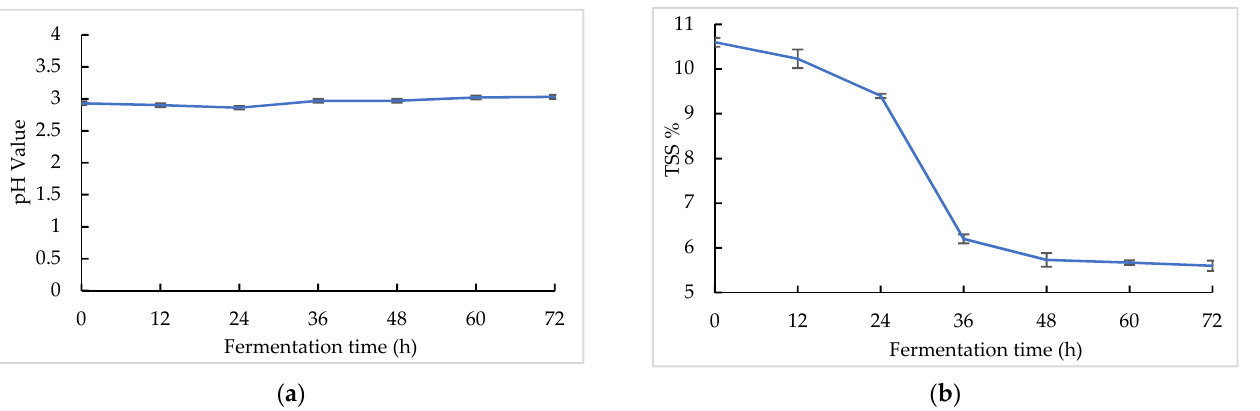
Figure 1. pH and TSS changes in sea buckthorn juice during fermentation: ( a ) pH change; ( b ) TSS change. 3.2. Color Changes in Sea Buckthorn Juice during Fermentation The color changes in sea buckthorn juice during fermentation is shown in Figure 2.